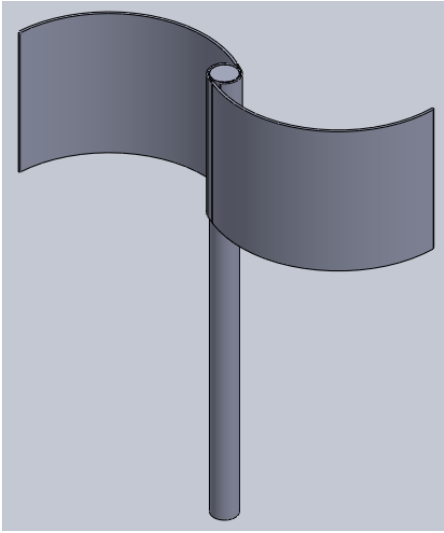
Figure 16. Savonius turbine.